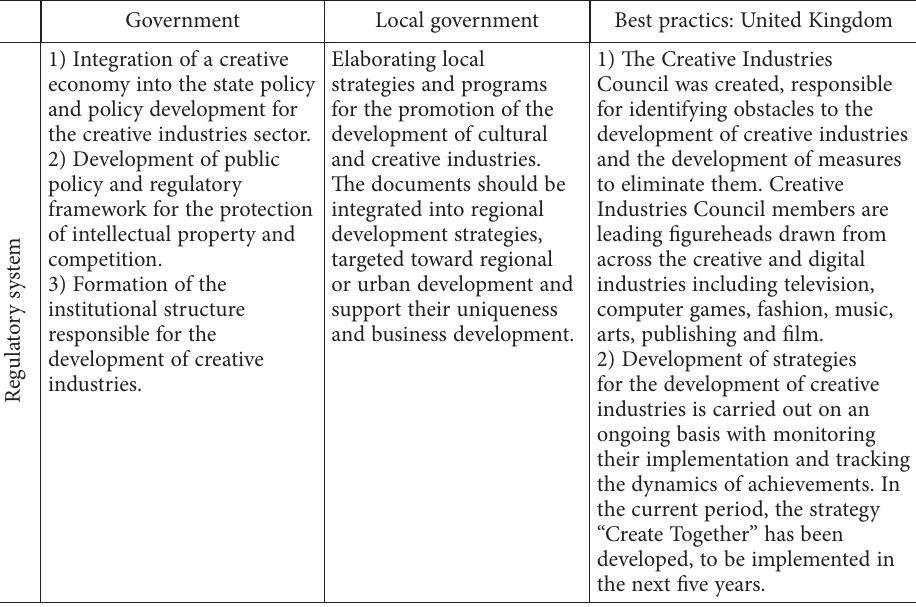
Table 4. Key actions for the development of creative industries in economies in transition (source: cre- ated by authors (based on Creative Industries Council, 2018; Working Group of EU Member States Ex- perts (Open Method of Coordination) on Cultural and Creative Industries, 2012; Bedianashvili,